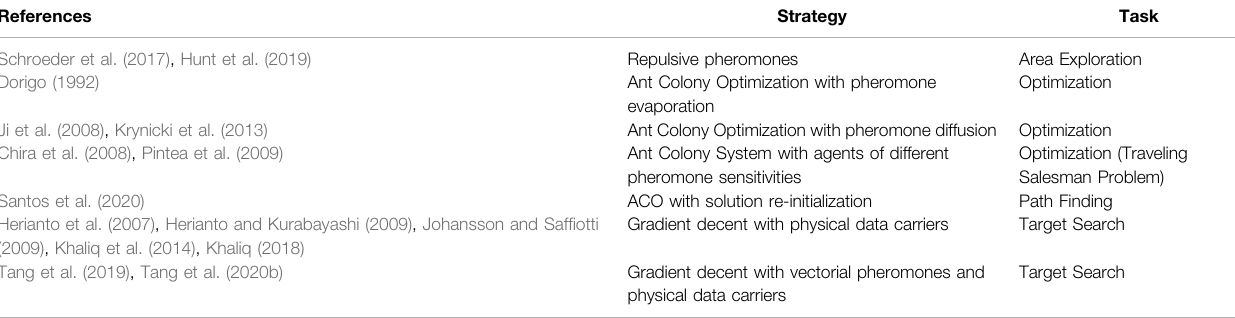
TABLE 9 | List of works using stigmergy to in fl uence the level of exploration and exploitation carried out by an